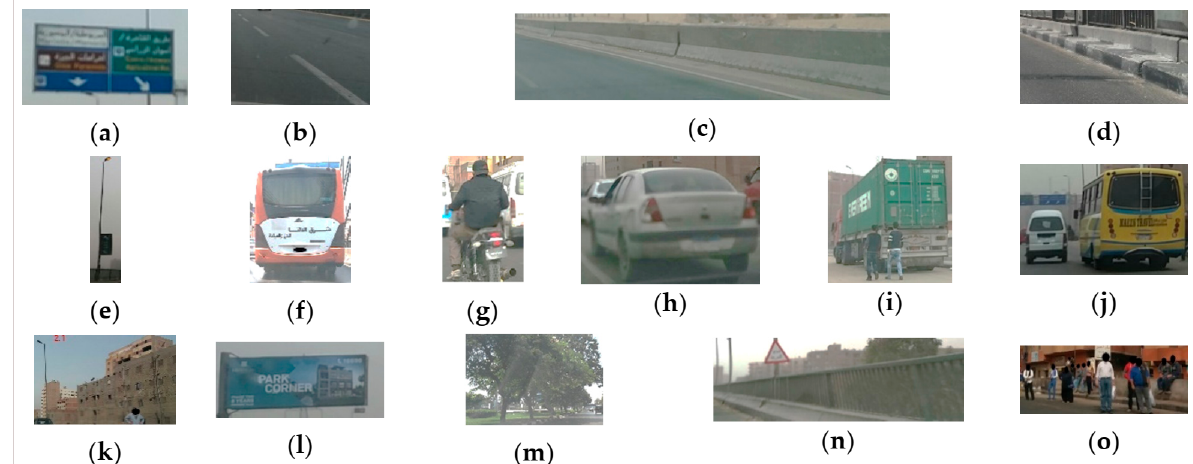
Figure 4. Roadway objects, from left to right and top to bottom: ( a ) traffic sign, ( b ) marking, ( c ) left and right barriers, ( d ) left and right curbs, ( e ) light pole, ( f ) bus, ( g ) motorcycle, ( h ) car, ( i ) heavy vehicle, ( j ) public transportation, ( k ) buildings, ( l ) billboards, ( m ) trees, ( n ) fence, and ( o ) pedestrian waiting